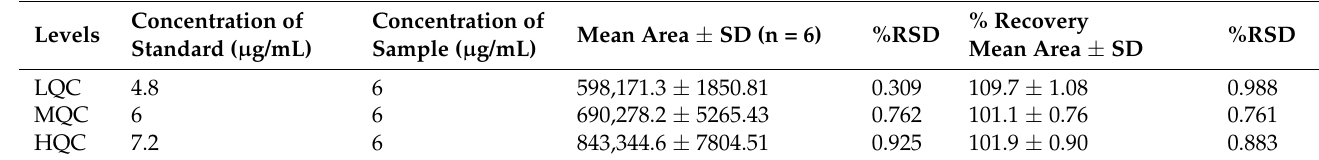
Figure 6. Depicting the chromatograms of ( A ) Xanthohumol and ( B ) calibration curve of XH Table 4. Represented accuracy data.